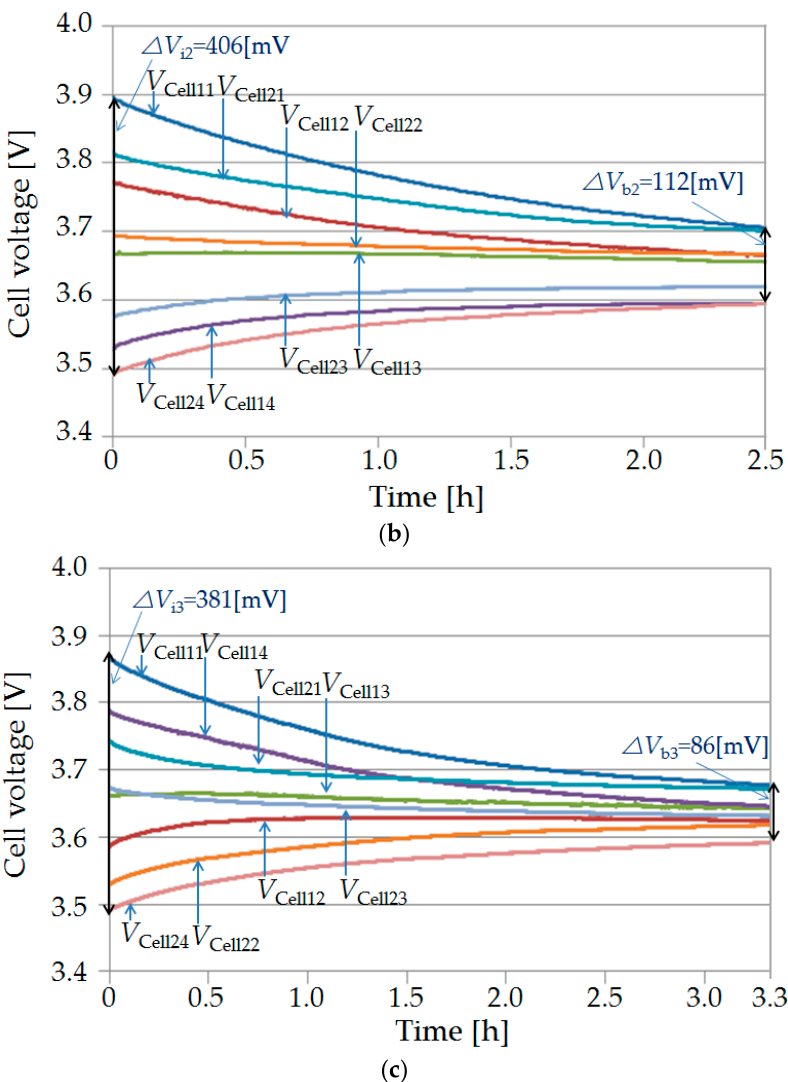
Figure 13. The experimental voltage results of eight cells: ( a ) Case 1; ( b ) Case 2; ( c ) Case 3.